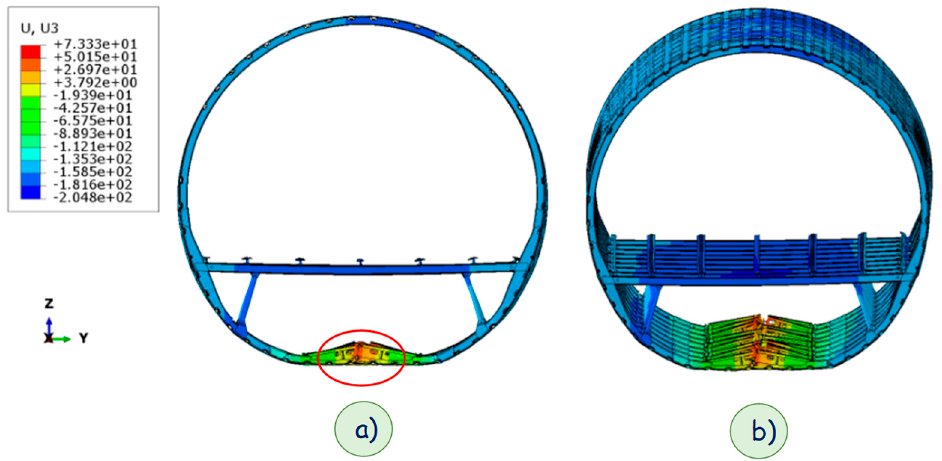
Figure 9. Fuselage section impact parallel to the ground: ( a ) Frontal view; ( b ) rotated view (units in mm).